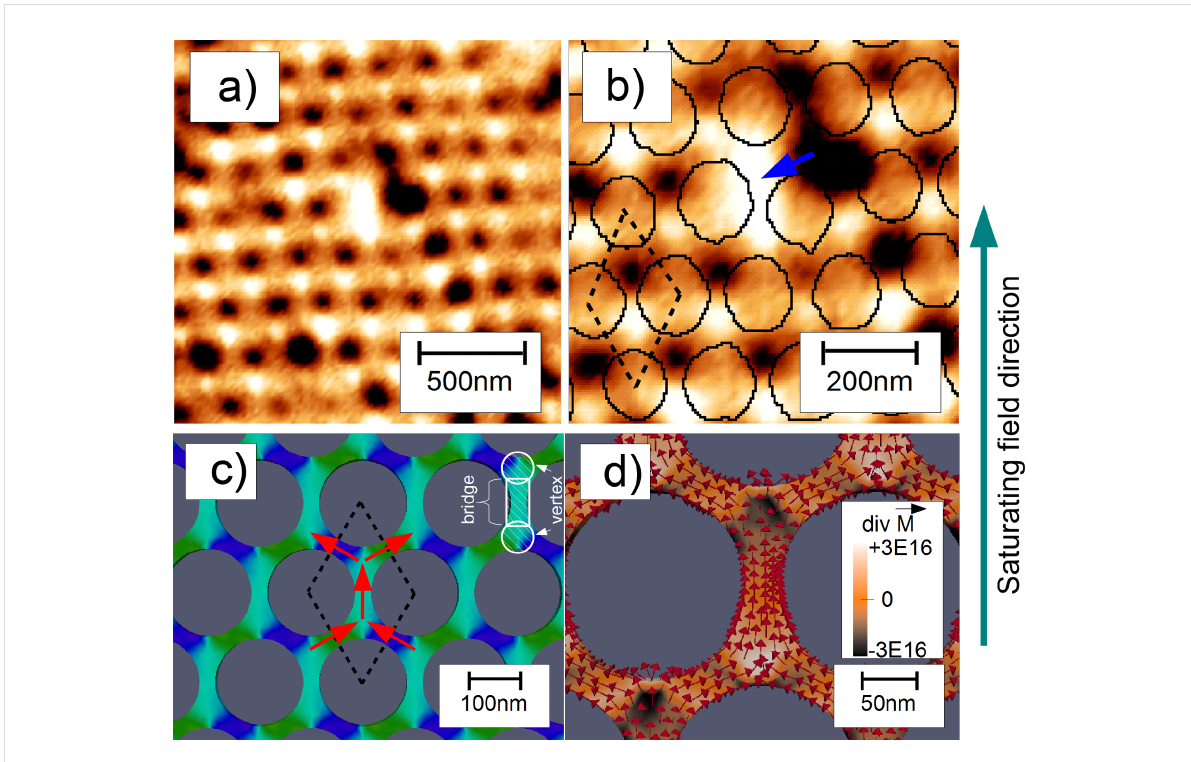
Figure 6: Domain pattern of hexagonal Fe antidot arrays with lattice parameter a = 200 nm and hole diameter d = 170 nm in the remnant state after saturation in an external field. (a) shows an 1.5 × 1.5 µm 2 MFM image while the positions of antidots as observed by AFM topography-scans and soft- ware recognition are added to panel (b) in a magnified region of (a). The tip–sample distance was set to 10 nm. In (b), the blue arrow indicates a single flipped bridge magnetisation. Panel (c) presents the simulated magnetisation pattern for the experimental antidot geometries. Red arrows indi- cate the direction of magnetisation in each domain of the unit cell (dashed lines). In panel (d) the colour code represents the magnetic charge distribu- tion derived from the magnetisation vectors (red arrows). Reproduced with permission from [16], copyright 2013 IOP Publishing